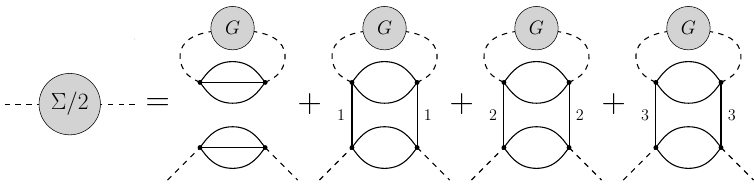
Figure 6 . Schwinger-Dyson equation at large N for the